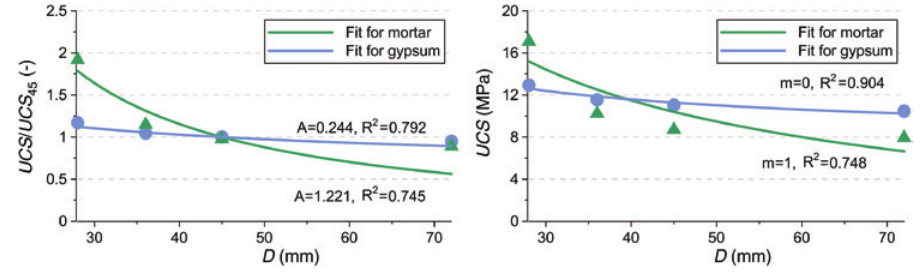
Figure 19: Fitting of the UCS data of mortar and gypsum by the functions (8) and (9),